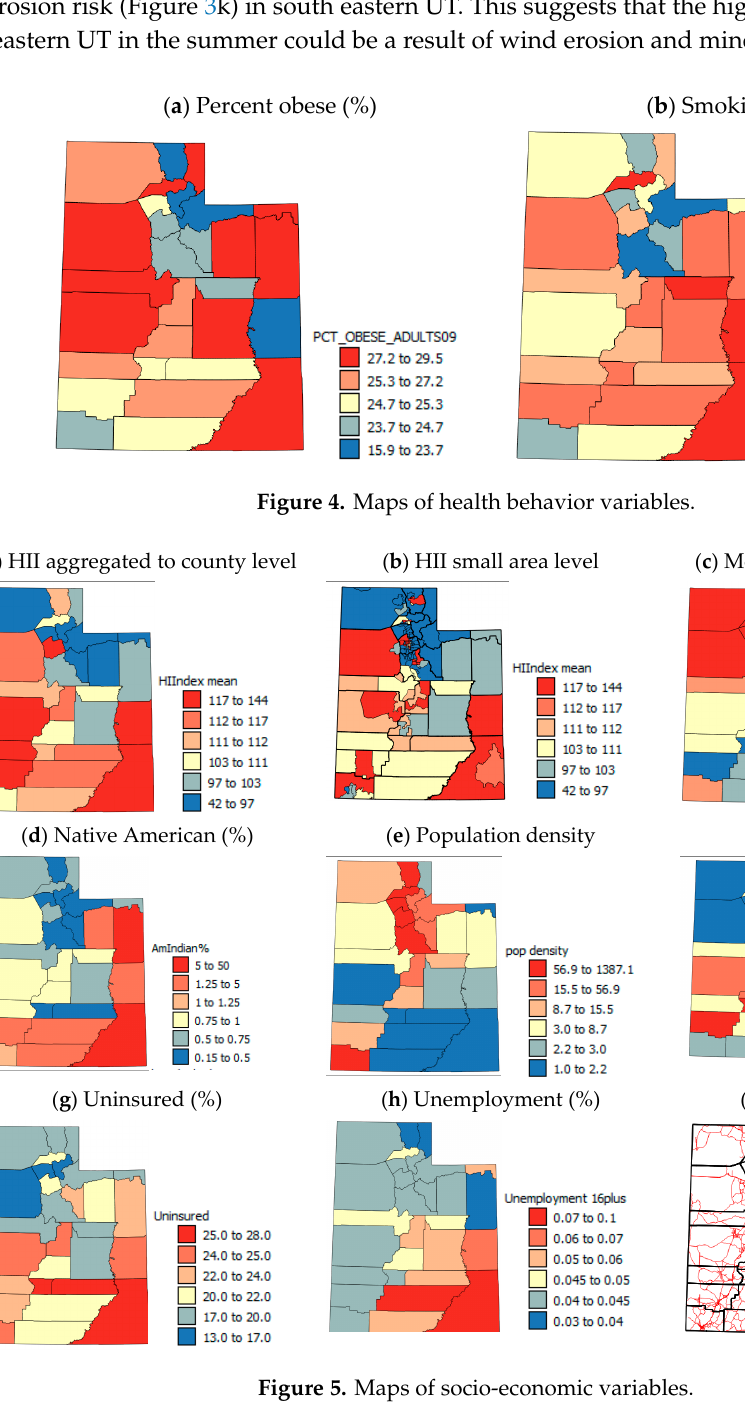
Figure 5. Maps of socio-economic variables.